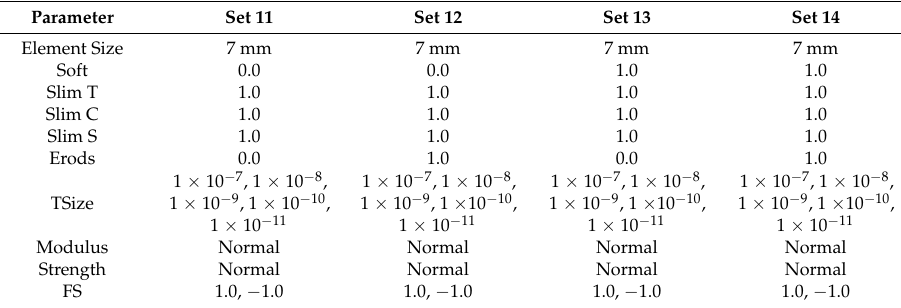
Table 9. Parameter used in different model runs (Part 3).